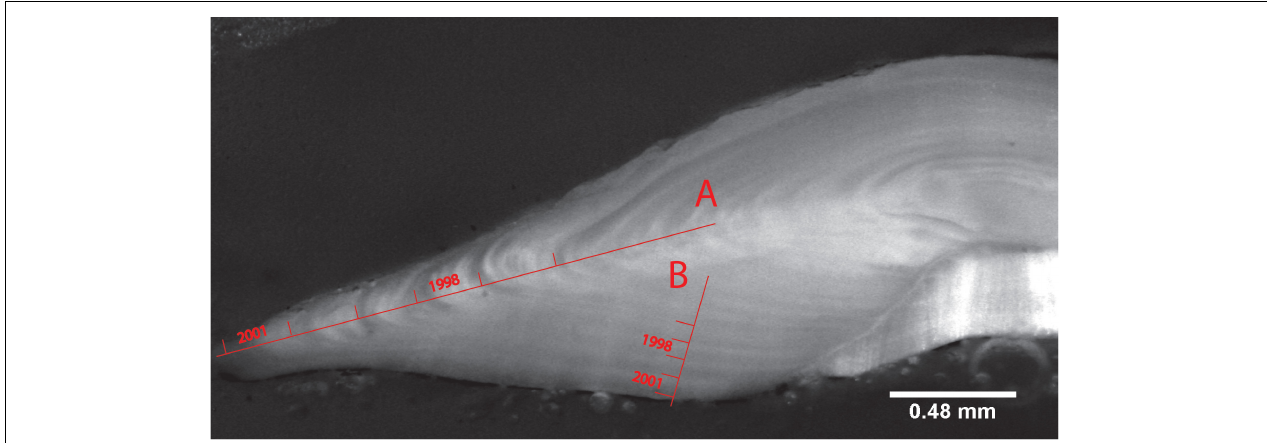
FIGURE 2 | Anterior view of a right-side sliced otolith of a 6-year old female M. paradoxus caught off Namibia in February 2002. The otolith is viewed with reflected light at 3.2 × magnification. Lines show the end of a growth zone marked with the years (spring to spring) that they represent on (A) the “long” axis and (B) the “short” nucleus-to-medial-edge